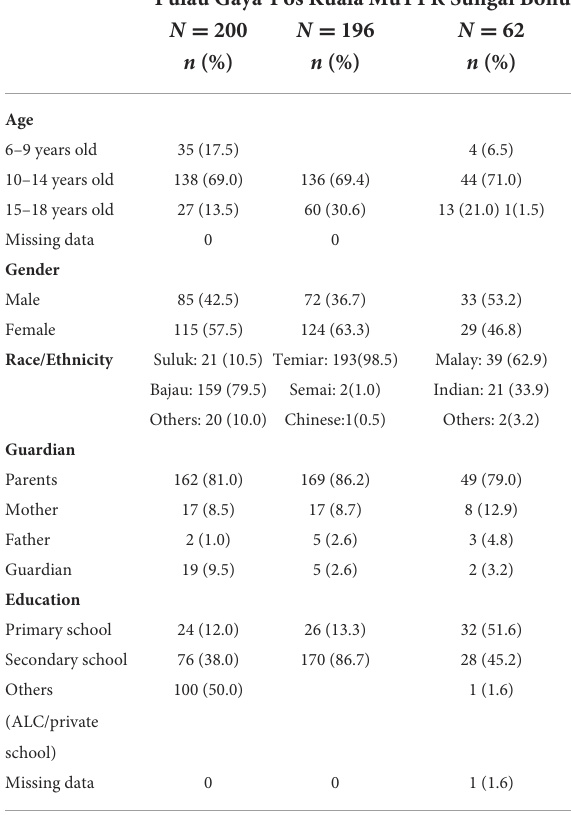
TABLE 4 Socio-demographic characteristics of participants in the cross-sectional